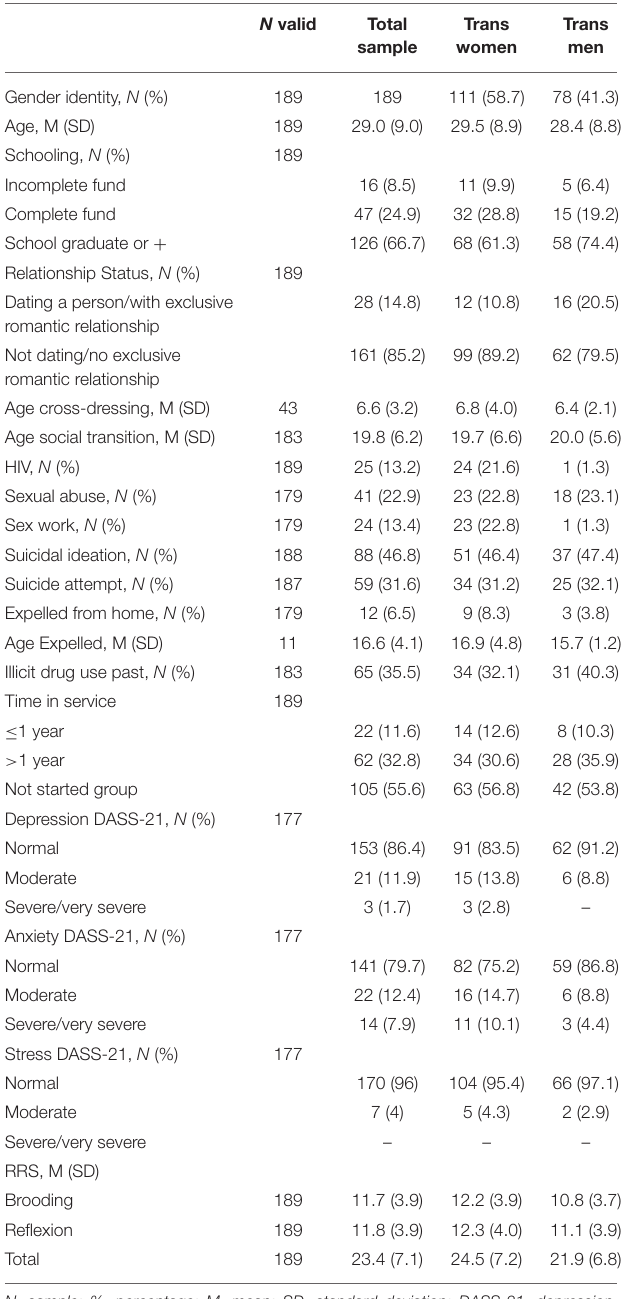
TABLE 1 | Sociodemographic, psychosocial, and clinical characterization of the sample.